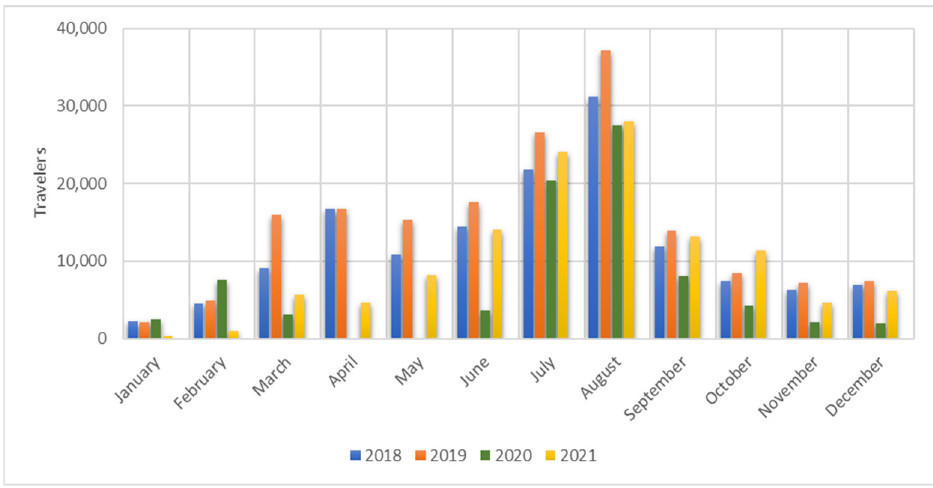
Figure 12. Graph of the evolution of total travelers during 2018, 2019, 2020 and 2021.